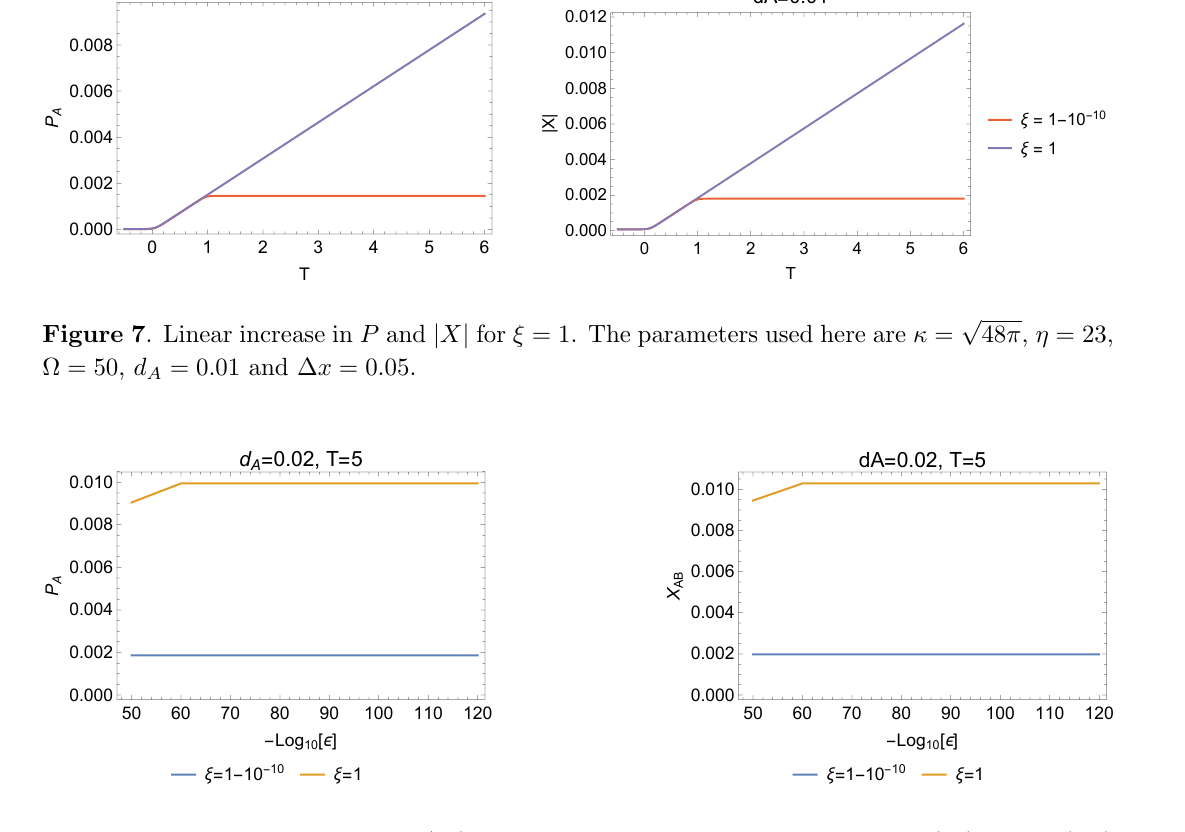
( (cid:15) = 10 (cid:0) 119 ) (cid:0) P ( (cid:15) = 10 (cid:0) 120 ) j (cid:25) 10 (cid:0) 6 and A A